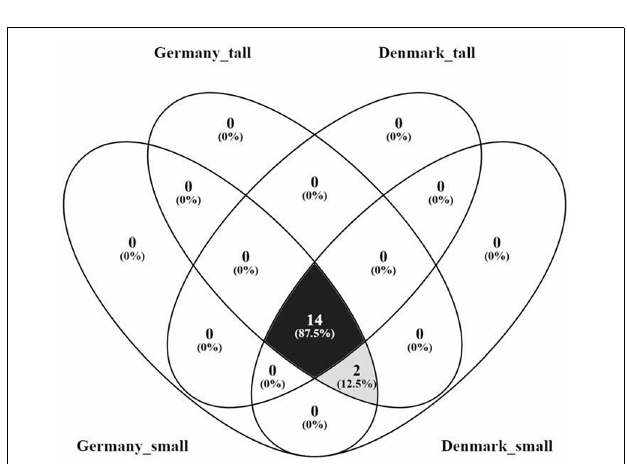
FIGURE 7 | Venn diagram of the core rhizosphere fungal microbiome of A. nordmanniana from tall and small plants collected in Germany and Denmark. Analysis was carried out at the order level. Numbers represent the amount of shared and unique OTUs for each variable. The numbers in parentheses show the percentage of contribution of the core OTUs in relation to the total number of OTUs